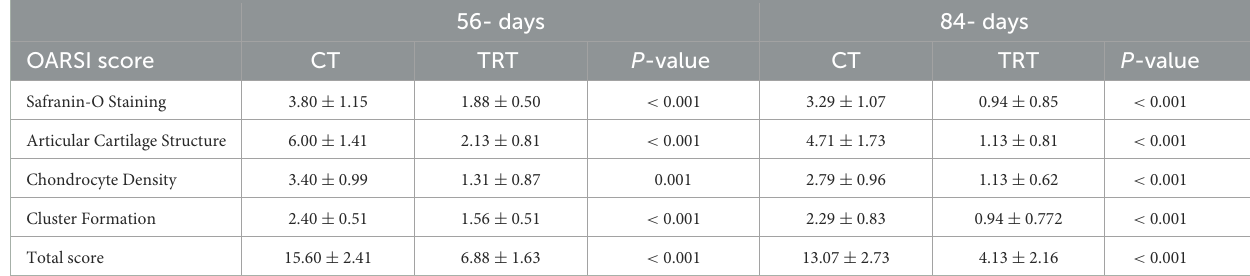
TABLE 3 OARSI score means, standard deviation and p -values.